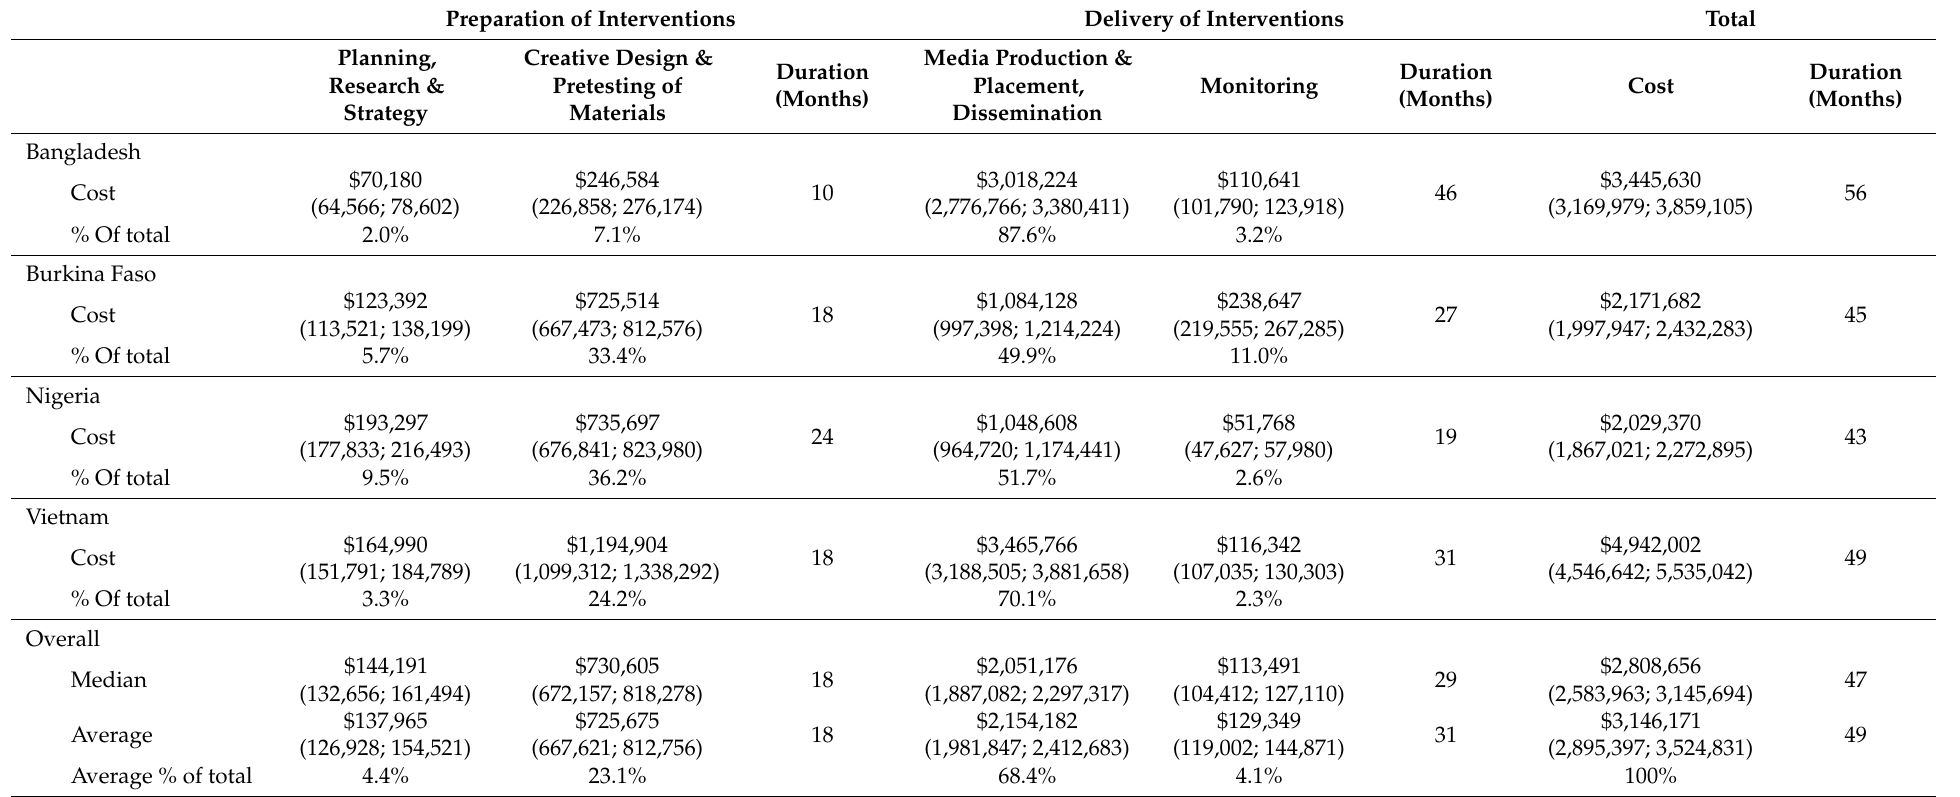
Table 2. Costs 1 and Durations of Program Components of Mass Media Interventions by Country (2019 USD). Preparation of Interventions Delivery of Interventions Total Planning, Creative Design & Media Production & Duration Duration Duration Research & Pretesting of Placement, Monitoring Cost (Months) (Months) Strategy Materials Dissemination